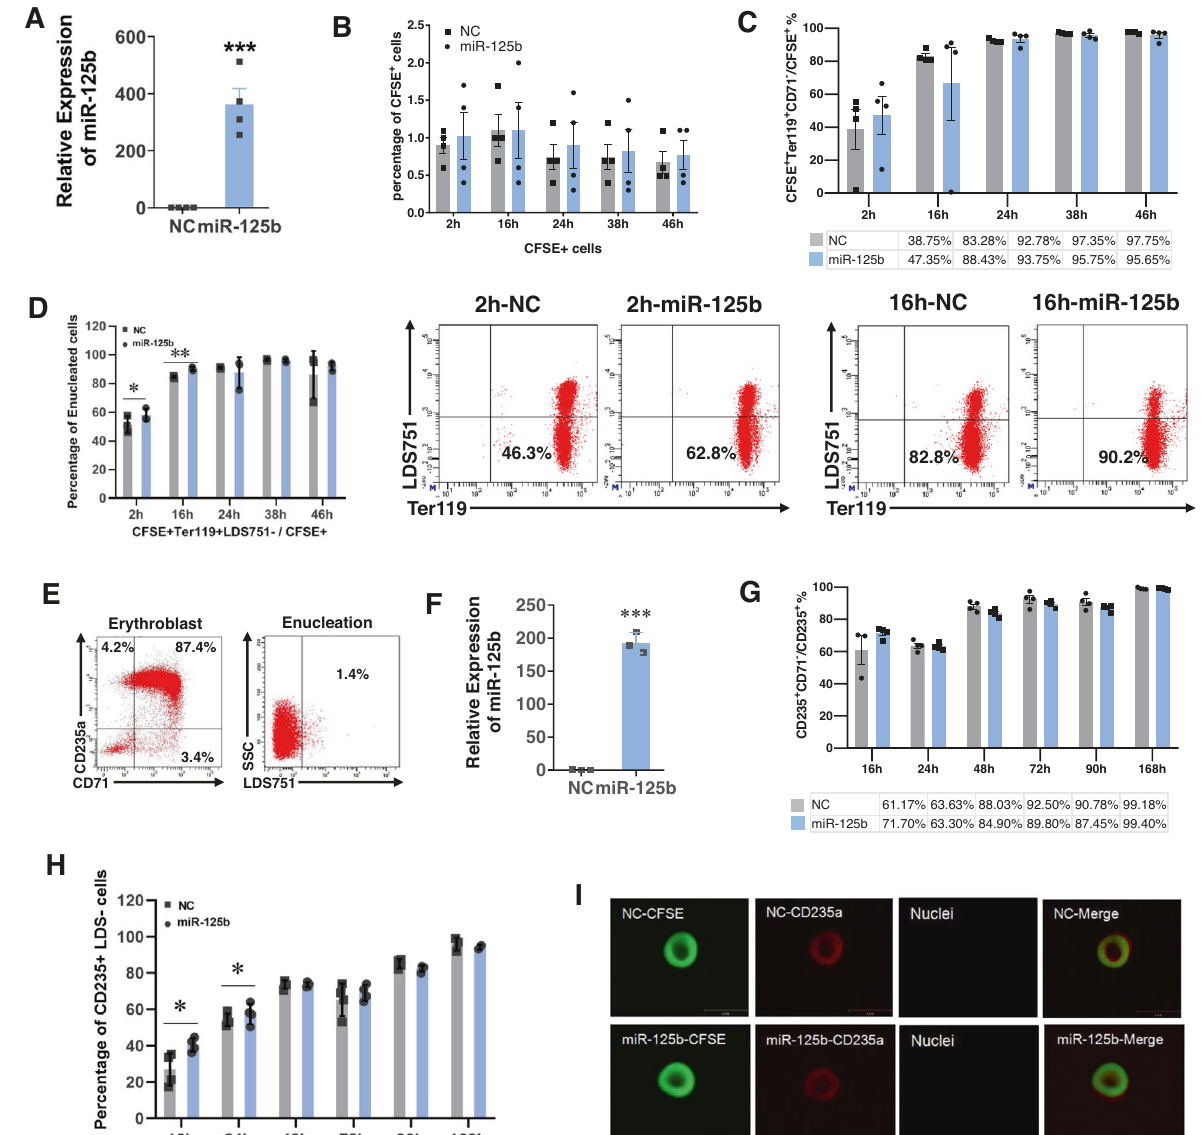
Fig. 4 miR-125b-5p increases the enucleation of mFL- and hCB-MNC-derived erythroblasts in vivo. A – D miR-125b-5p increases mFL- derived erythroblast enucleation in vivo. A qRT-PCR shows the relative expression of miR-125b-5p after miRNA mimic transfection. U6 was the loading control, and the results are expressed as the mean ± SD ( n = 4; p = 0.0006). B The kinetics of CFSE-labeled erythroblast retention in mouse PB after infusion. The results are expressed as the mean ± SD ( n = 4). C The percentage of TER-119 + CD71 − populations in CFSE + erythroblasts was increased after cell infusion. D Compared to the control, miR-125b-5p overexpression promoted early stage enucleation of infused erythroblasts, especially at 2 and 16 h post infusion. Representative fl ow cytometry analysis shows the enucleation percentage at 2 and 16 h. Quantitative analysis of three independent experiments is shown as the mean ± SD ( p = 0.044 and p = 0.003 for 2 and 16 h, respectively). E – I miR-125b-5p increased hCB-MNC-derived erythroblast enucleation in vivo. E Immediately before infusion, most hCB-MNC- derived erythroblasts were CD235a and CD71 double positive and nucleated (LDS751 positive). F qRT-PCR analysis of the relative expression of miR-125b-5p after miRNA mimic transfection. U6 was the loading control, and the results are expressed as the mean ± SD ( n = 3; p = 2.90811E-05). G In recipient mouse PB, the percentage of CD71 − populations in CD235a + human erythroblasts was increased after cell infusion. H Compared to the control, miR-125b-5p overexpression increased the early stage enucleation of infused human erythroblasts, especially at 16 and 24 h post infusion. The quantitative analysis of four independent experiments is shown as the mean ± SD ( p = 0.0307 and p = 0.0353 for 16 and 24 h, respectively). I Representative confocal microscopy images of enucleated cells sorted using the human CD235a surface marker from recipient mouse PB. No difference in morphology or CD235a expression was detected between the miR-125b-5p overexpression group and the control group. erythroblast enucleation. We hypothesized that during physiolo- DISCUSSION gical erythroblast maturation, miR-125b-5p accumulates to In the present study, the unique role of “ ubiquitous ” miR-125b-5p provide a fi nal push for enucleation and that Bcl-2 is a mediator in erythroblast enucleation was discovered. Through endogenous of gene function with the fi nal outcome being cytoskeletal miR-125b-5p expression analysis and gene gain- and loss-of- rearrangement and enucleation. Because in vitro-induced RBCs, function studies, we con fi rmed the positive role of miR-125b-5p in Cell Death and Disease (2022)